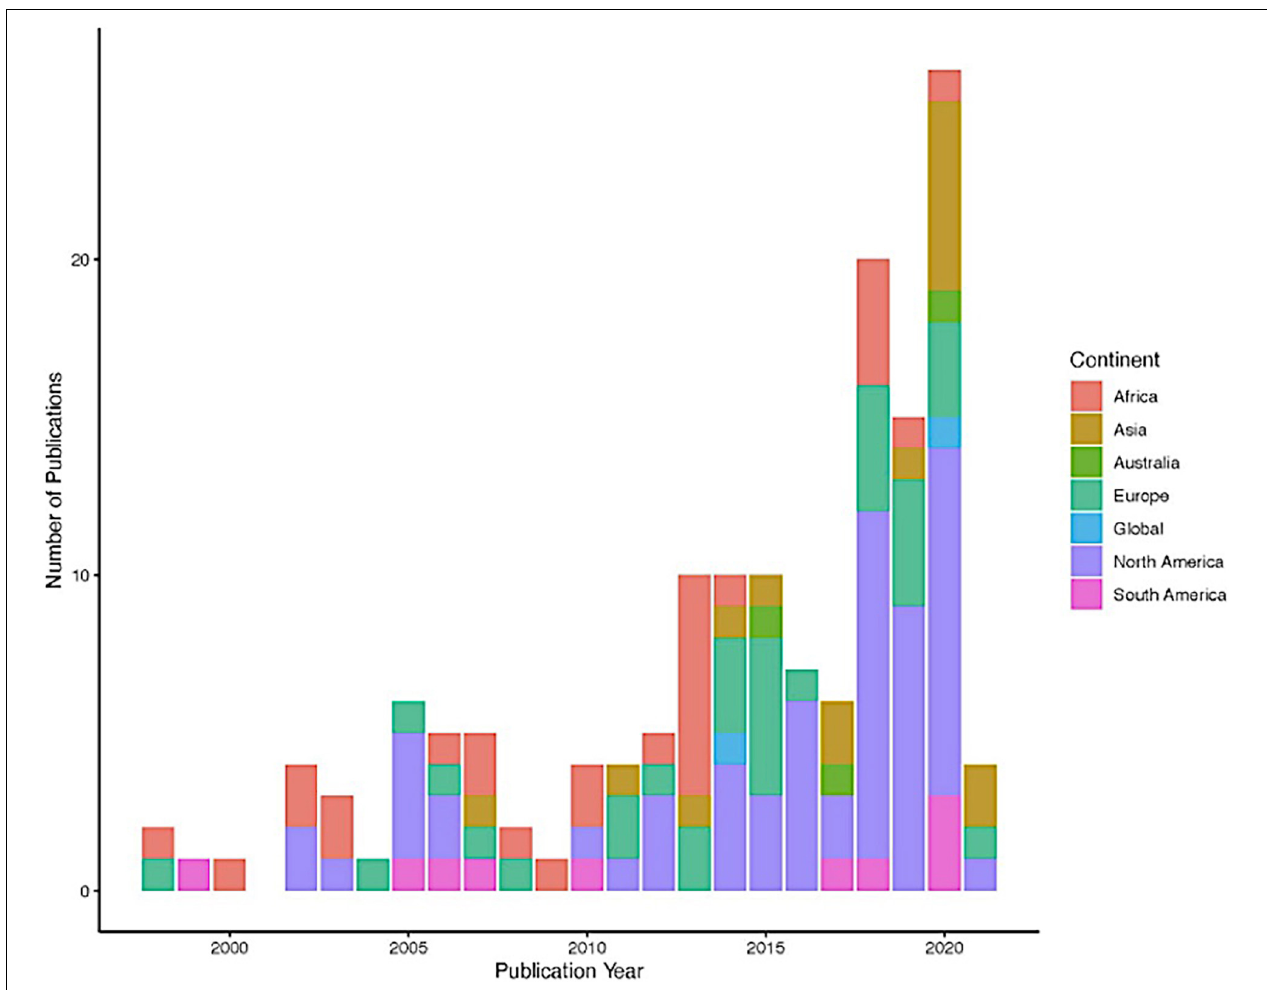
FIGURE 2 | Timeline of included published tick species distribution